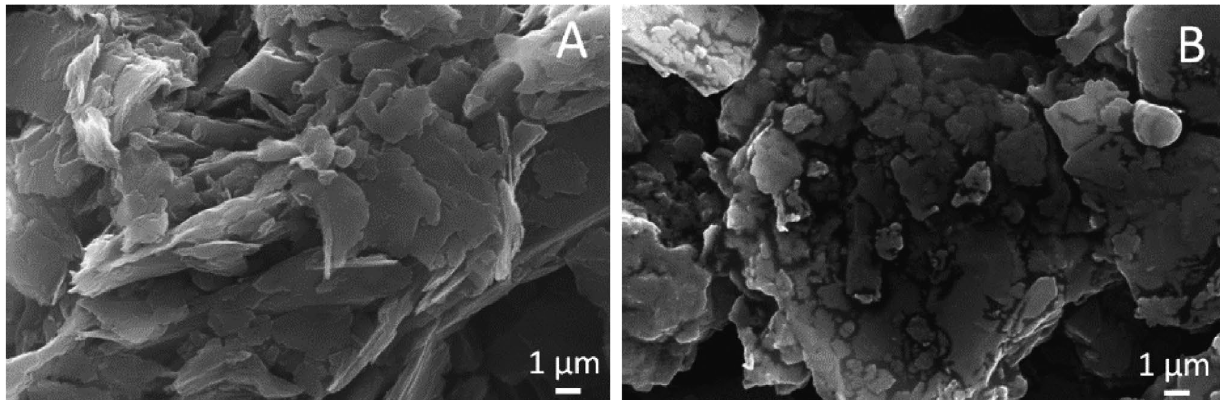
Fig. 3. SEM images of bare carbon paste (A) and modified carbon paste (B) with